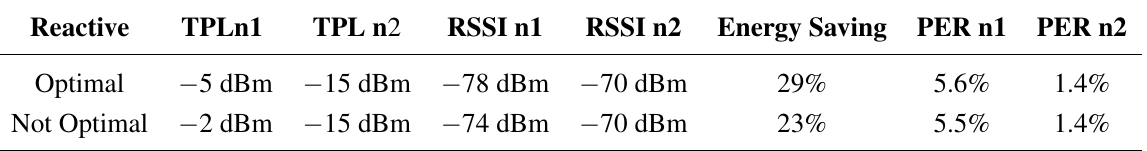
Table 5. Simulation results for the reactive algorithm in the best case. PER, packet